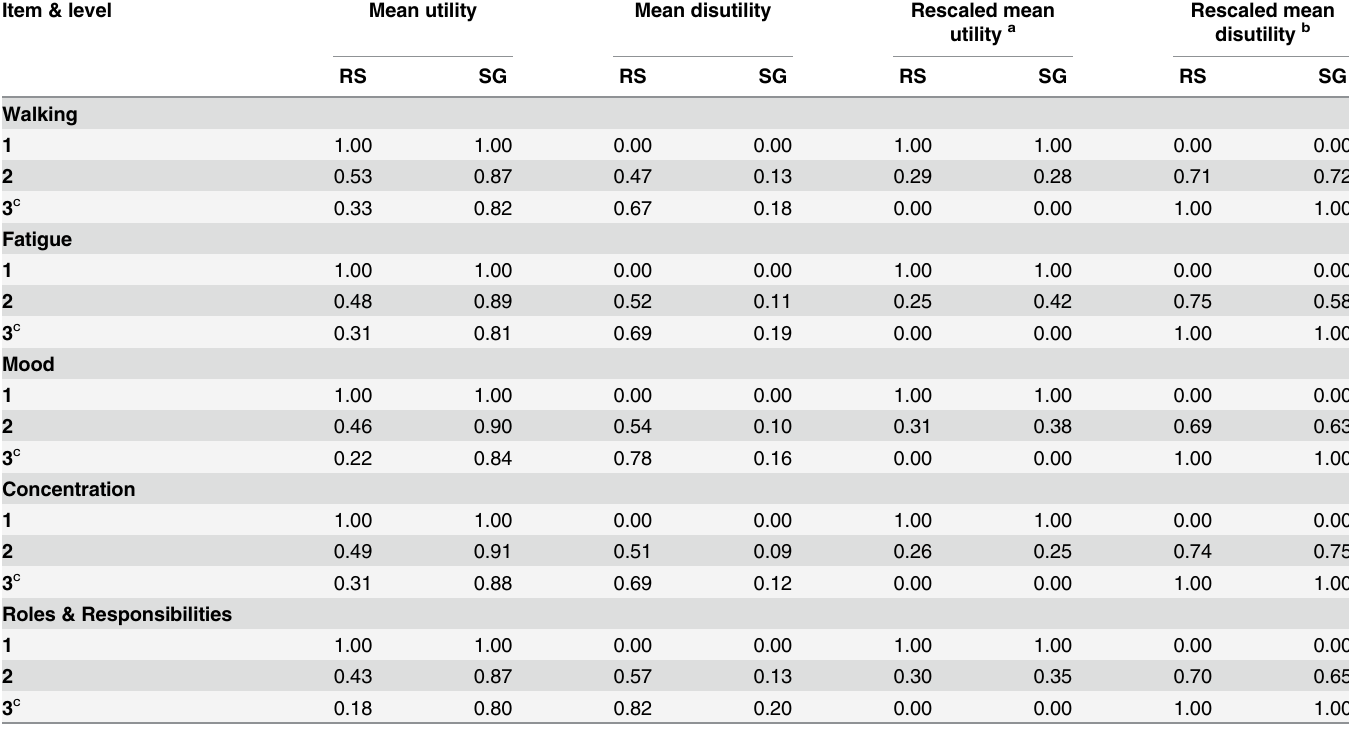
Table 5 presents the parameters used to develop the MAUF based on the RS and SG values D obtained in the development sample. The first column presents the mean RS and SG utility val- ues for each response level, where level 1 was the best, level 2 was intermediate, and level 3 was the worst. The first level of each item was 1.0 (perfect health). As expected, there was a drop in utility values from level 1 to level 2 to level 3. For each item, response level 3 was the corner Table 5. Calculation of parameters in the estimation of the PBMSI MAUF D in the Development sample. Item & level